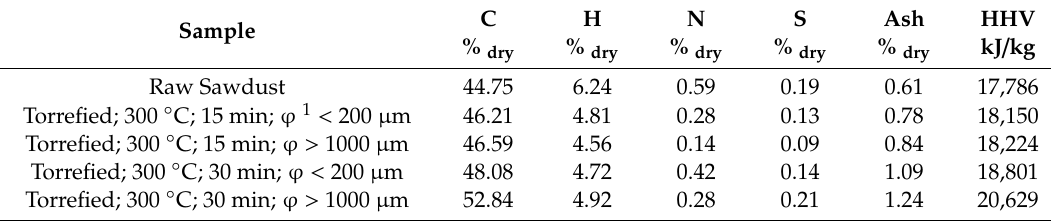
Table 1. Ultimate analysis and higher heating value of raw and torrefied